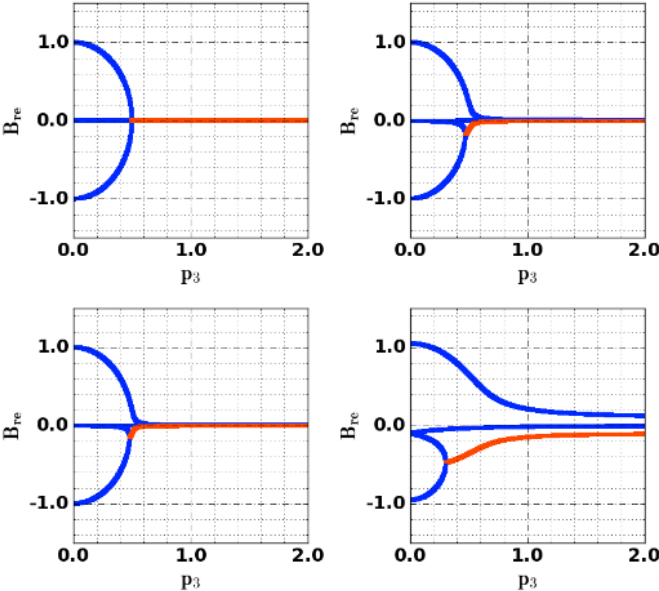
Figure 4. The solution of MN gap equations as a function of momentum. Blue color represents real solutions and red complex for η = 1 GeV: (top left) chiral quark ( m = 0); (top right) up quark ( m = 3 MeV); (bottom left) down quark ( m = 5 MeV); and (bottom right) strange quark ( m = 100 MeV). All quantities are displayed in units of η . Figure from